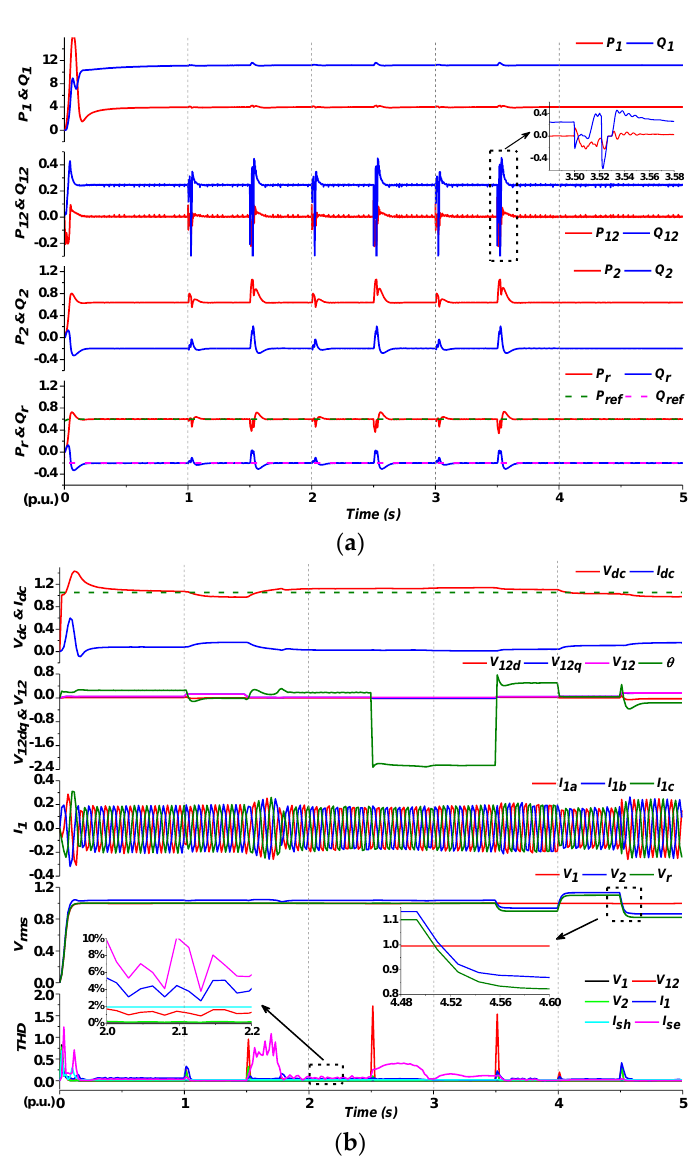
Figure 21. The simulation results of case 2. ( a ) The results of the power flow of each part; ( b ) The results of other important parameters.